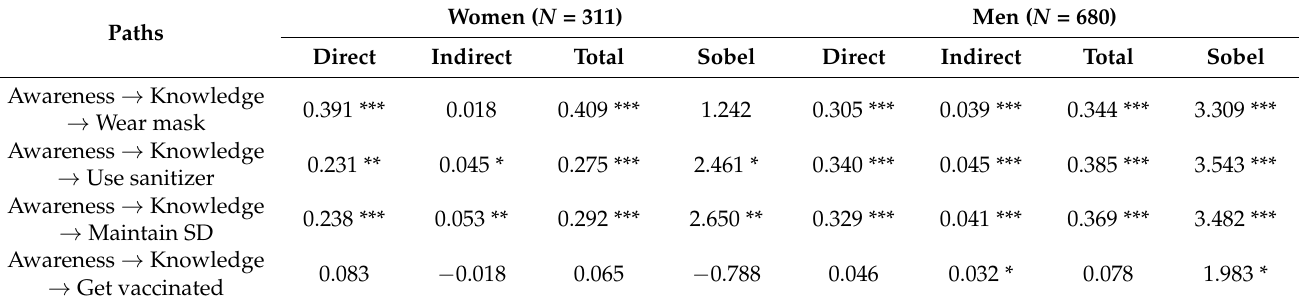
Table 4. Mediation effects of COVID-19 awareness on students’ protective behaviors